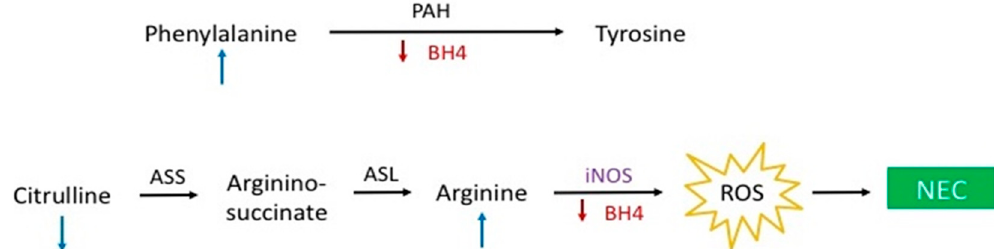
Figure 4. Potential hypothesis outlining the role of tetrahydrobiopterin (BH4) and nitric oxide (NO) in the pathophysiology of necrotizing enterocolitis (NEC).